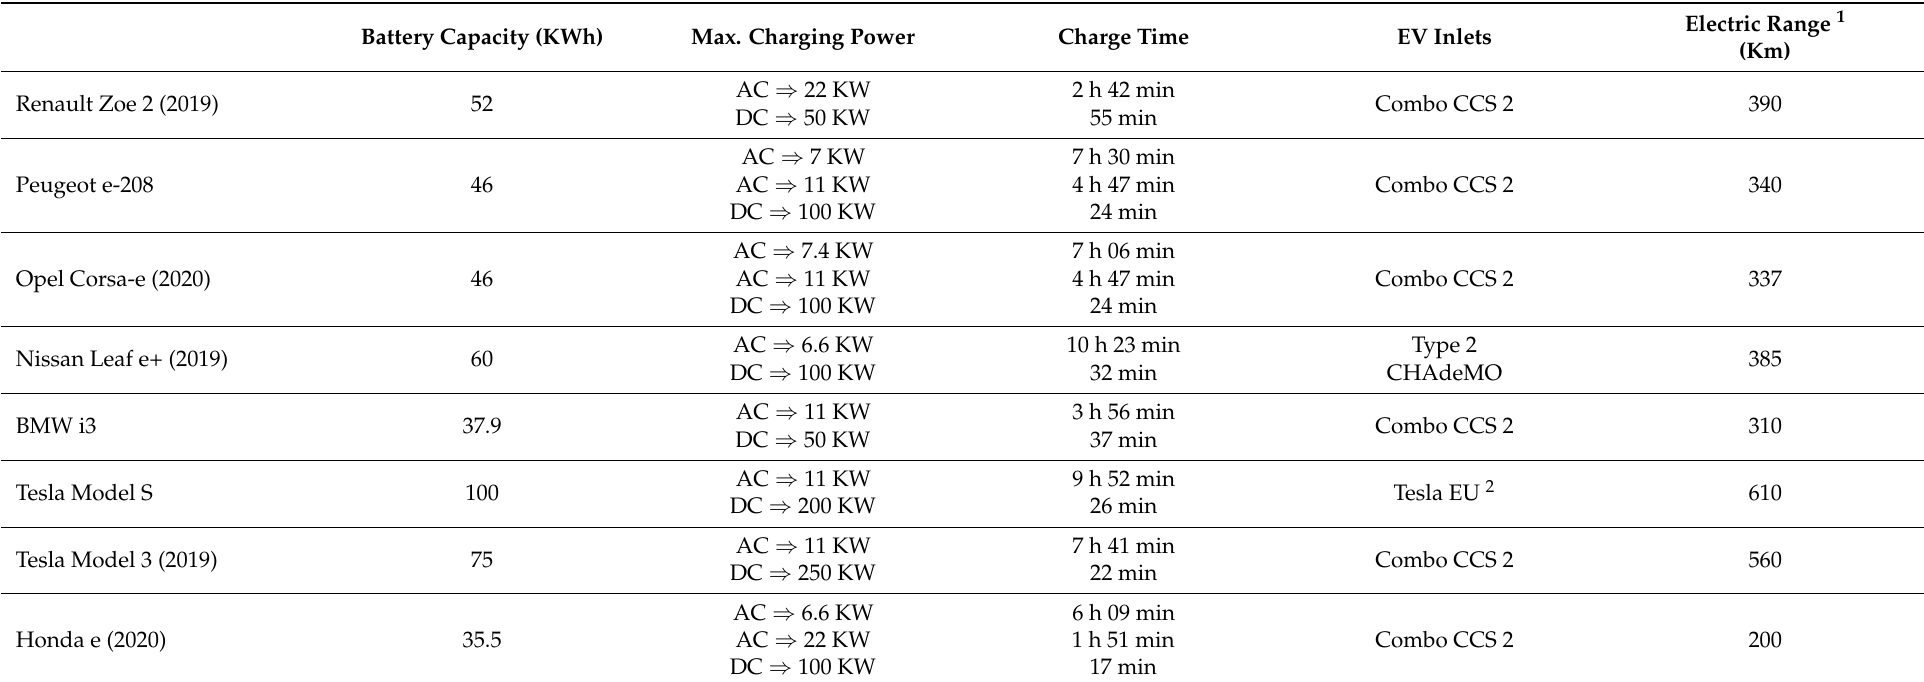
Table 7. The most common EV compatible with type 2